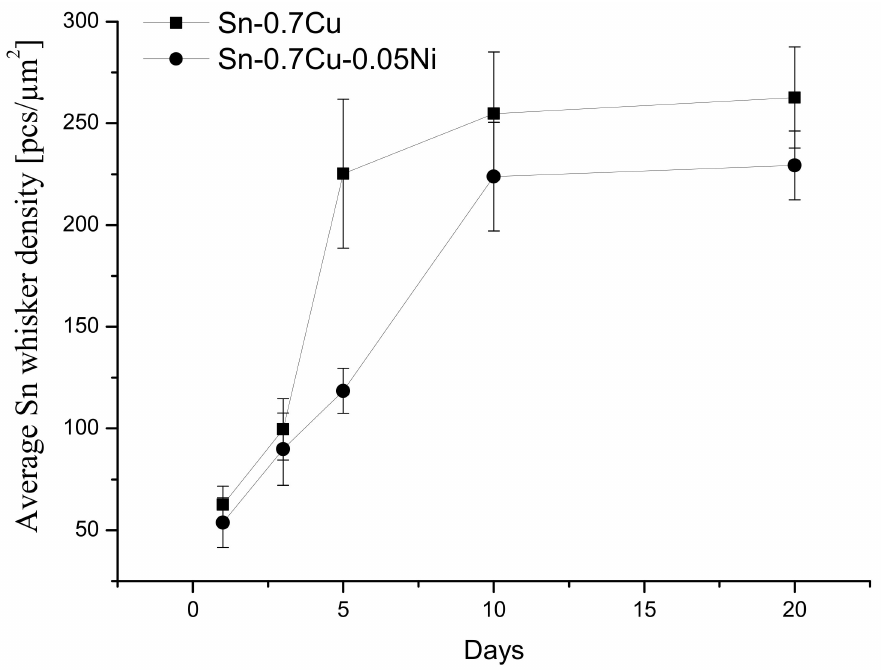
Figure 6. The average density of Sn whiskers in Sn-0.7Cu and Sn-0.7Cu-0.05Ni solder